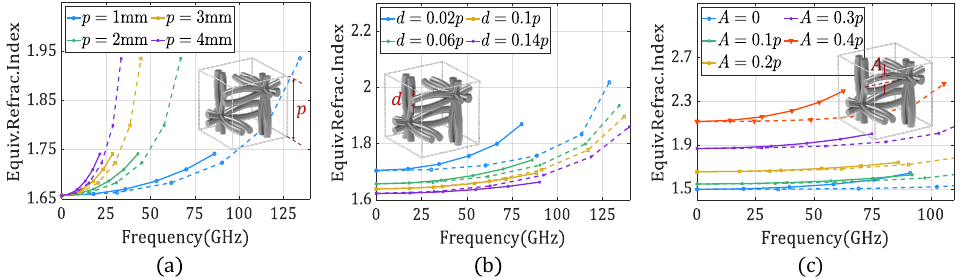
Figure 3. Effective refractive index of the double-mesh twin-wire unit cell as a function of: ( a ) period p ; ( b ) diameter of wire d ; ( c ) amplitude of undulation A . The solid lines represent the data for Γ X, and the dashed lines for Γ R. Unless otherwise specified, the dimensions are A = 0.2mm, N = 1, p = 1mm, and d =